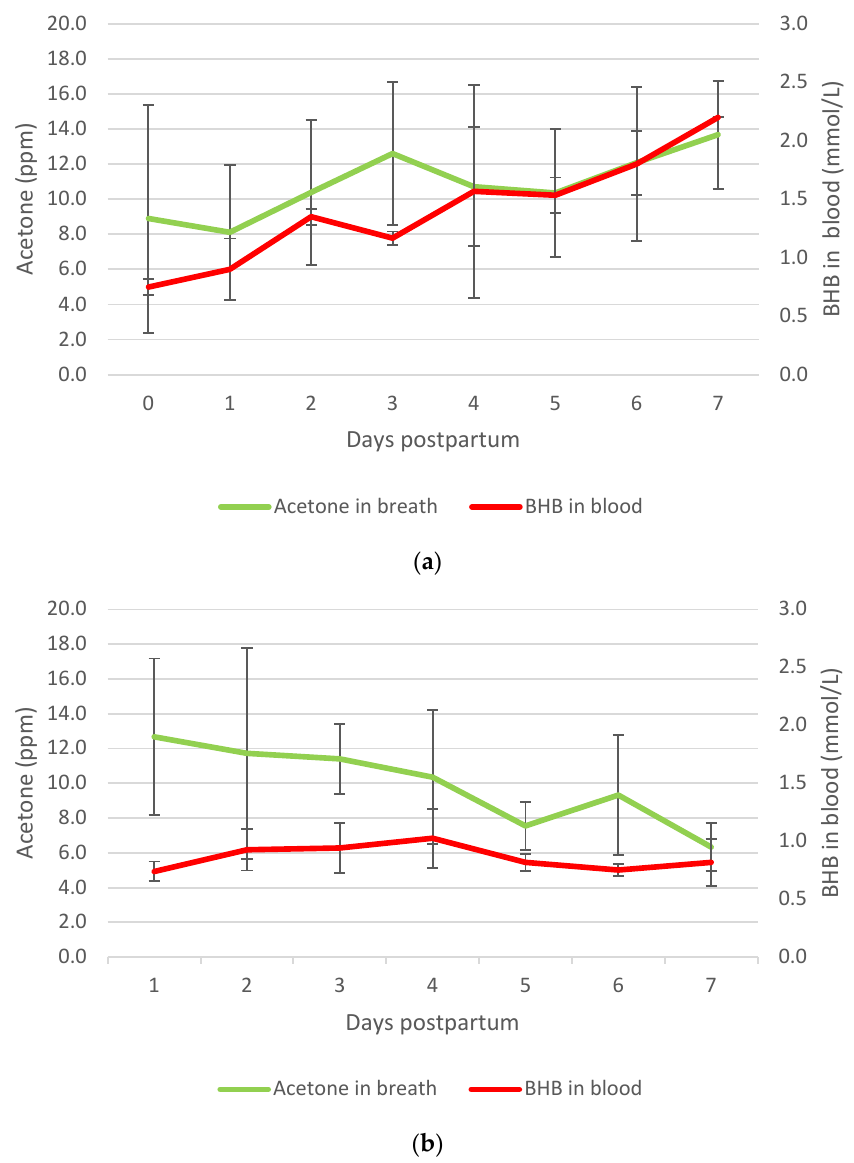
Figure 7. ( a ) Acetone concentrations in breath and BHB concentrations in blood (±SD) for four ketotic cows, daily samples until seven days postpartum. ( b ). Acetone concentrations in breath and BHB concentrations in blood (±SD) for three non-ketotic cows, daily samples until seven days postpartum.